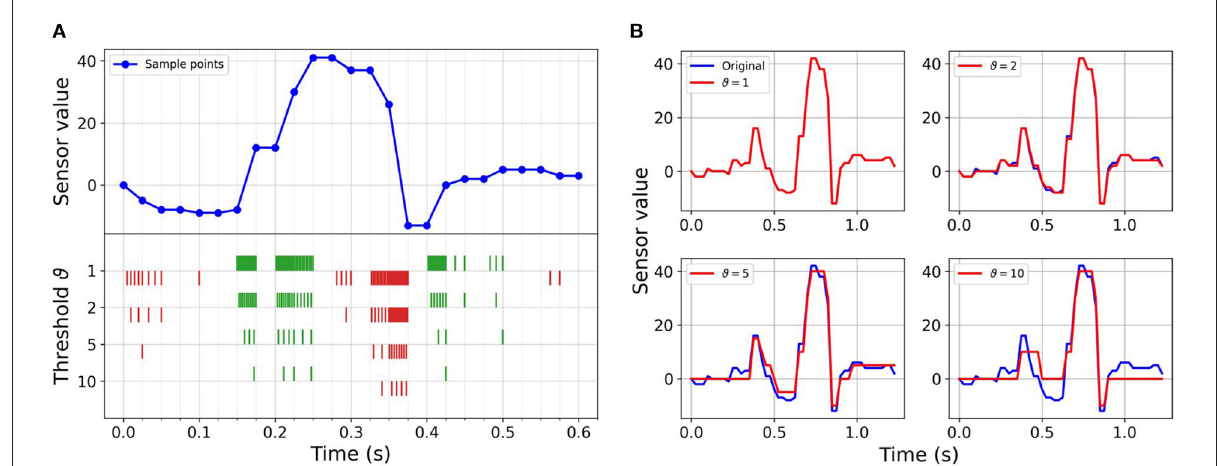
FIGURE3 Event-based encoding and reconstruction of a sample: (A) Sensor reading sequence of a sample letter along with spikes generated using sigma-delta modulation. The upper part represents 600 ms of a sequence of sensor readings of a single taxel during sliding. The bottom part shows the generated events for the ON (green color) and OFF (red color) channels for increasing threshold values, leading to decreasing numbers of events. (B) Reconstructed sequence from event-based data compared with the original sequence for a full letter sequence. Each plot represents the reconstruction with a different threshold of the same frame-based sequence. Increasing thresholds increase the compression, but also increase the reconstruction